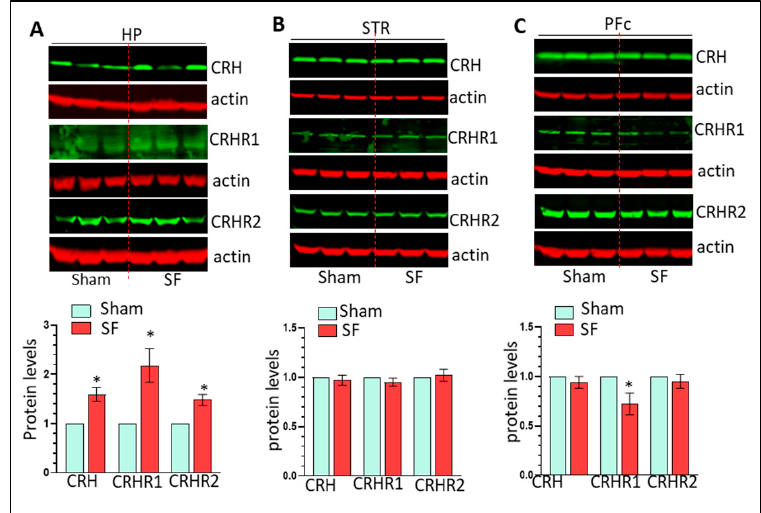
Figure 3. Three-weeks of SF selectively increases CRH system activity in the brain. ( A ): three-weeks of SF increases the levels of CRH, CRHR1, and CRHR2 levels in the HP (n = 6, * p < 0.05); ( B , C ): three-weeks of SF has no effects on CRH system in the striatum and